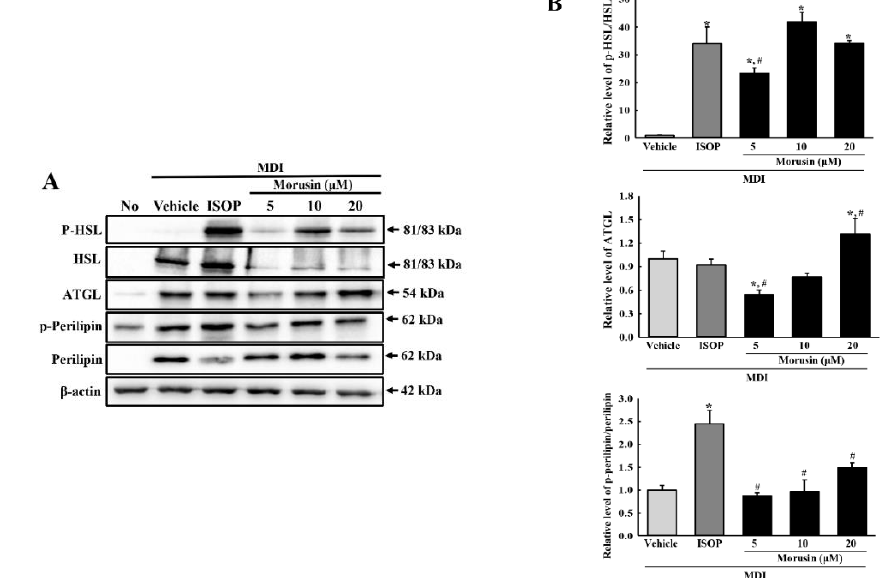
Figure 6. Expression analysis of lipolytic proteins. ( A ) After the incubation of MDI + morusin in 3T3-L1 adipocytes, the expression levels of HSL, ATGL, perilipin and β -actin were detected with specific antibodies, followed by horseradish peroxidase-conjugated goat anti-rabbit IgG. ( B ) Band intensities were measured using an imaging densitometer, and the relative levels of each protein was calculated relative to the intensity of actin bands. The data represents the means ± SD of three replicates. * indicates p < 0.05 compared to the untreated group. # indicates p < 0.05 compared to the MDI + vehicle-treated group. OT; orlistat, MDI; adipogenic cocktail consisting of 3-isobutyl-1-methylxanthine, dexamethasone, and insulin.